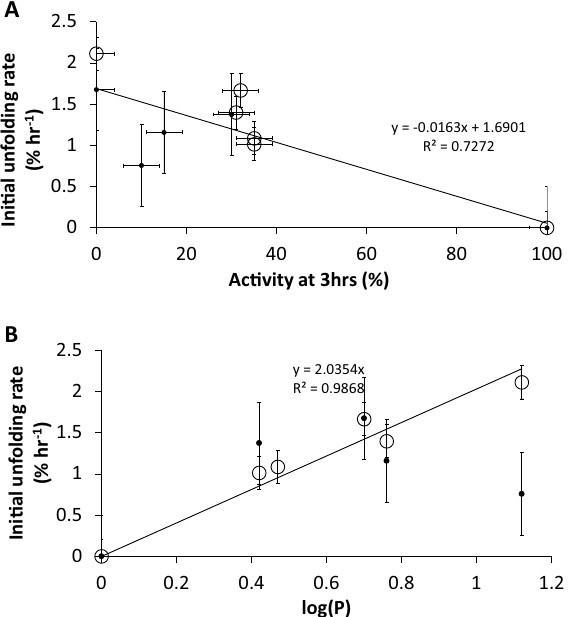
Figure 6. ( A , B ) Relationship between the local unfolding rate, retained activity after 3 h, and log(P). Both plots exclude MeCN as this solvent unfolded the protein globally. Apo-TK (open circle) and holo-TK (filled circle) Error bars represent one standard deviation about the mean (n =